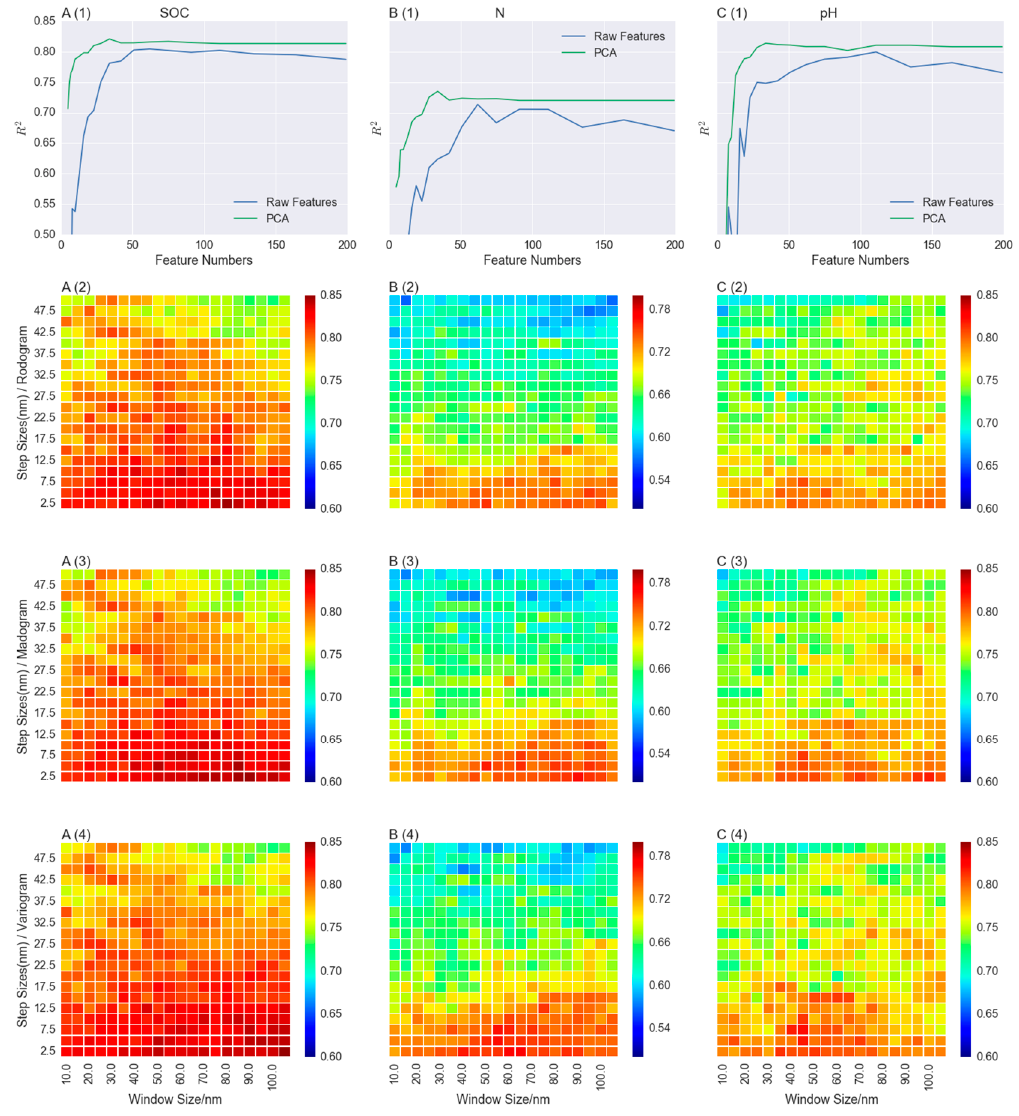
Figure 6. Gradient-boosting regression modelling accuracies for SOC, N and pH. ( A1 ), ( B1 ) and ( C1 ) were with principal component analysis (PCA)-transformed features and raw spectra; ( A2 ), ( B2 ) and ( C2 ) were with fractal features derived by the rodogram method with various step-scale pairs. ( A3 ), ( B3 ) and ( C3 ) were with fractal features derived by the madogram method with various step-window pairs. ( A4 ), ( B4 ) and ( C4 ) were with fractal features derived by the variogram method with various step-scale pairs.